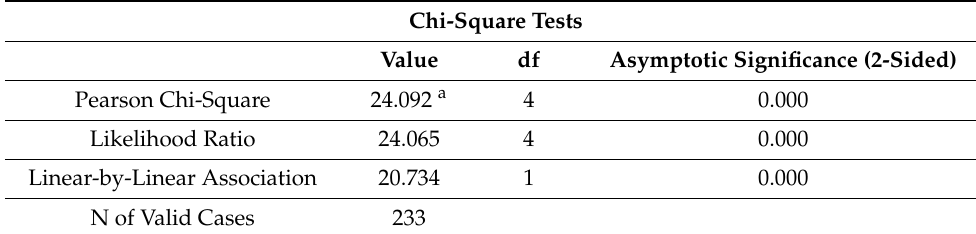
Table 5. Crosstabulation of (Q11) and (Q12).